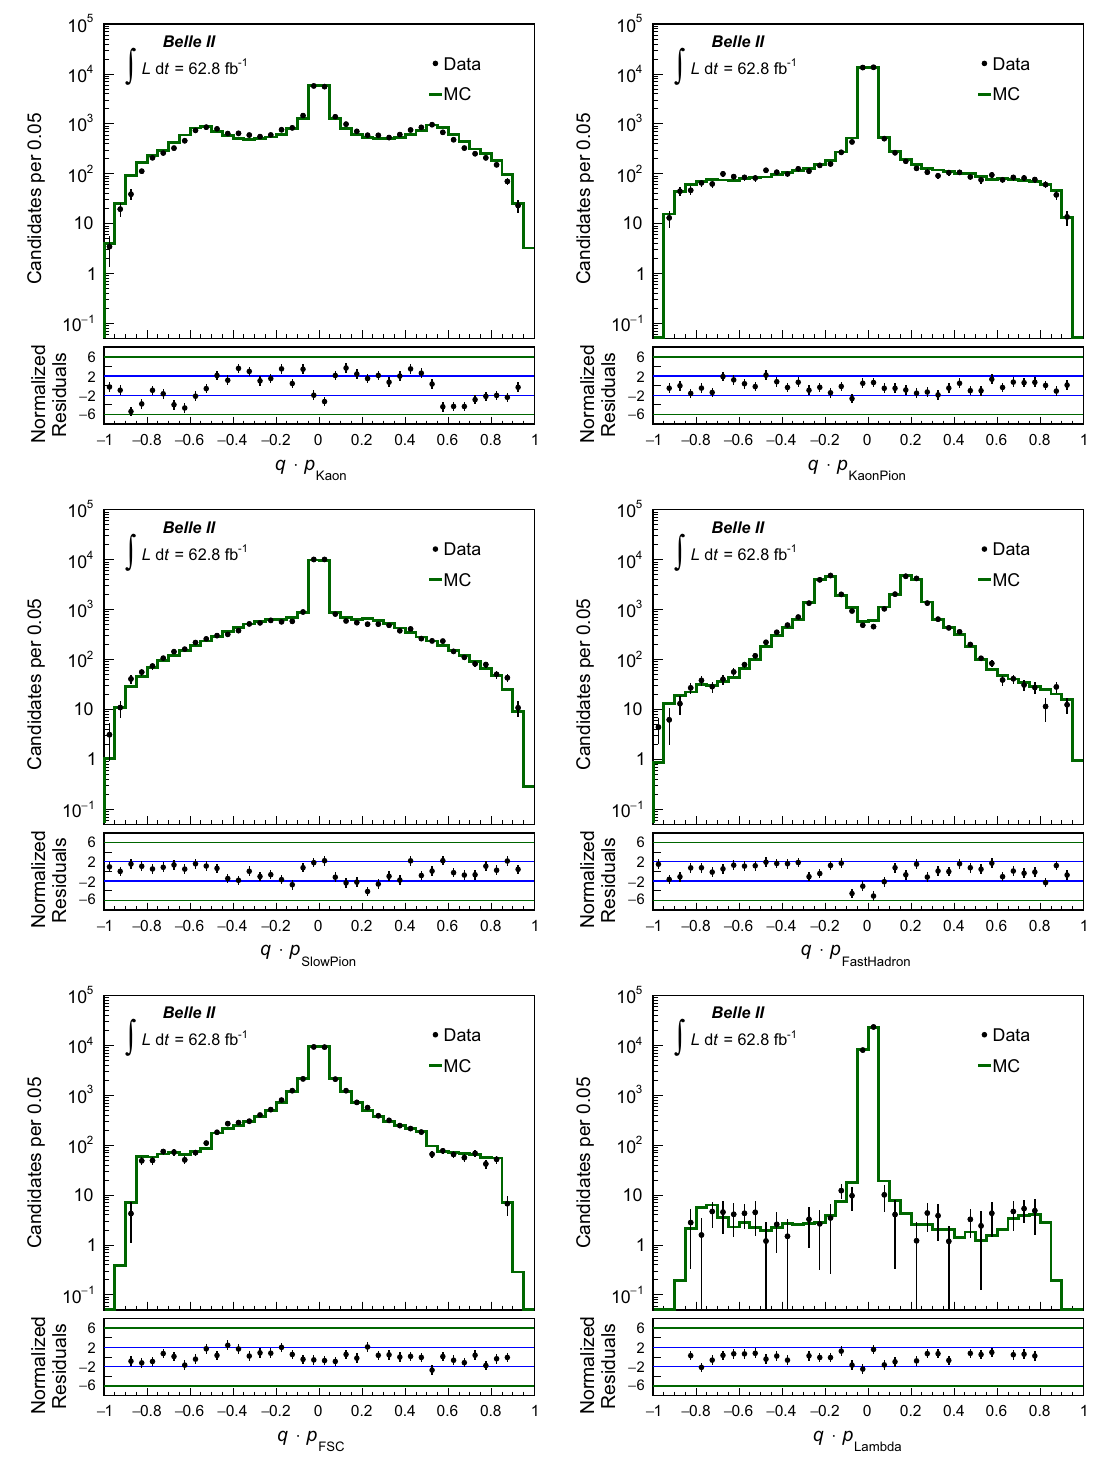
Fig. 10 Normalized output distributions of the Kaon, Kaon-Pion, Slow Pion, Fast Hadron, Fast-Slow-Correlated, and Lambda categories in data ( ∗ ) − + h candidates. The contribution from the signal component in data is compared with correctly associated signal and MC simulation for B 0 → D MC